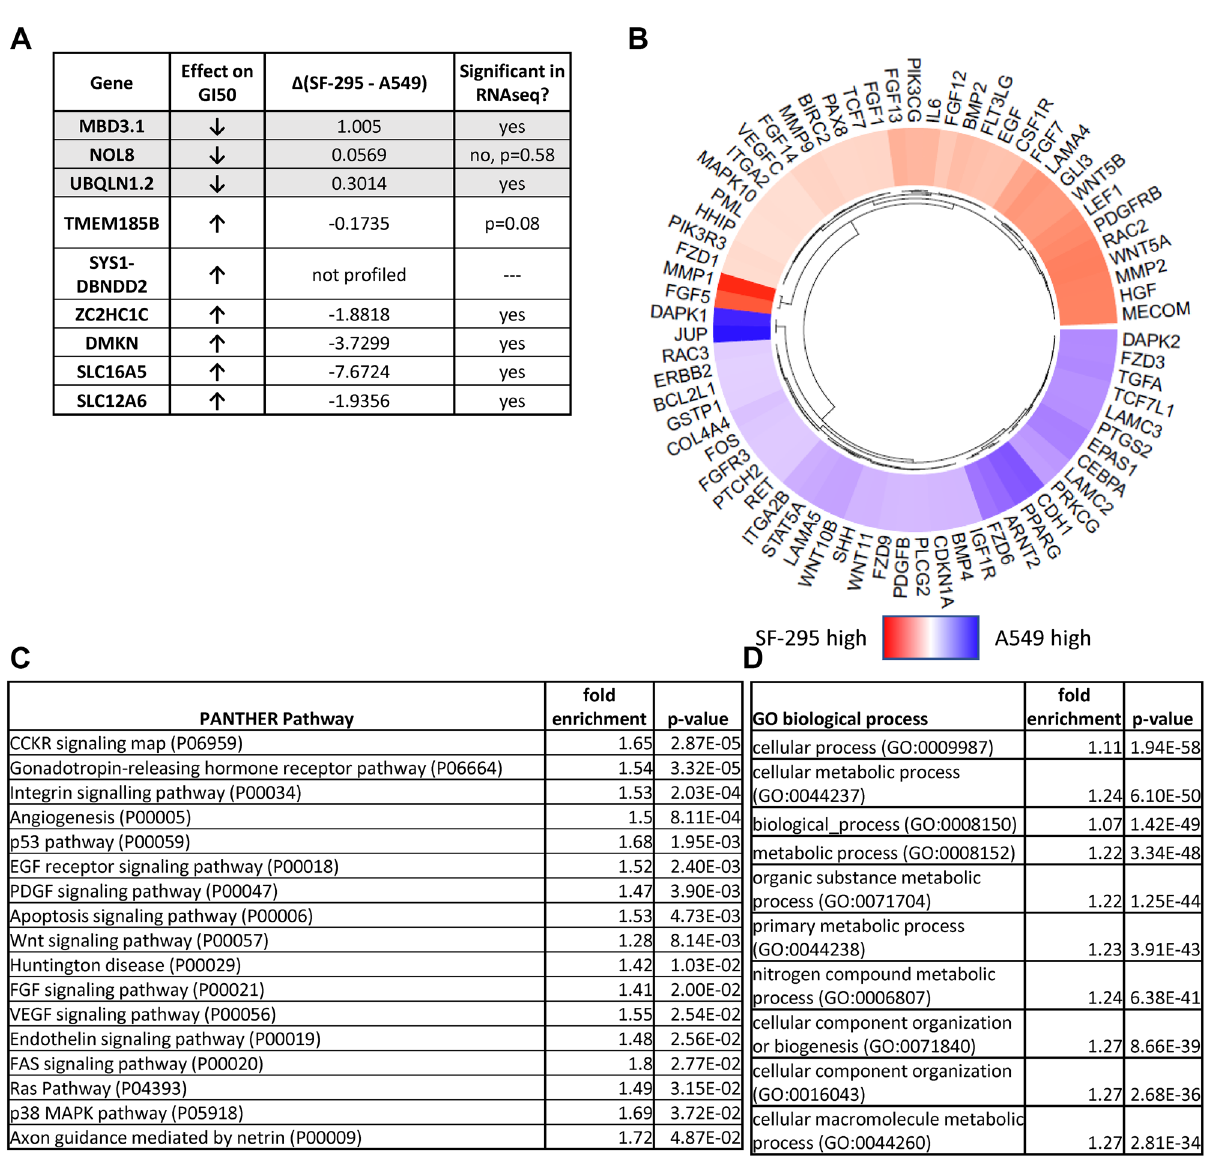
Figure 3. Sensitive SF-295 glioma and resistant A549 lung cancer cells have different gene expression profiles. Untreated SF-295 and A549 cells were analyzed by RNA sequencing. ( A ) Genes identified in the LASSO regression of Fig. 1B compared to RNAseq analysis. (Five-and ten-fold cross-validation comparisons are identified in Supplementary Fig. 2). Most genes identified via LASSO had significantly different expression levels in SF-295 and A549. ( B ) heat map of significantly differentially expressed genes in untreated SF-295 and A549 cells. Genes present in the GSEA geneset “KEGG Pathways in Cancer” with |log fold difference|> 2 were included in the heatmap. Full data is provided in Supplementary Tables 2–3. ( C ) Gene set enrichment analysis of untreated SF-295 and A549 cells with PANTHER pathways was carried out using significantly differentially expressed (adj. p value < 0.05) genes. ( D ) Top hits for GO biological process analysis at 24 h; further reactome and GO pathway analyses are included in Supplementary Table